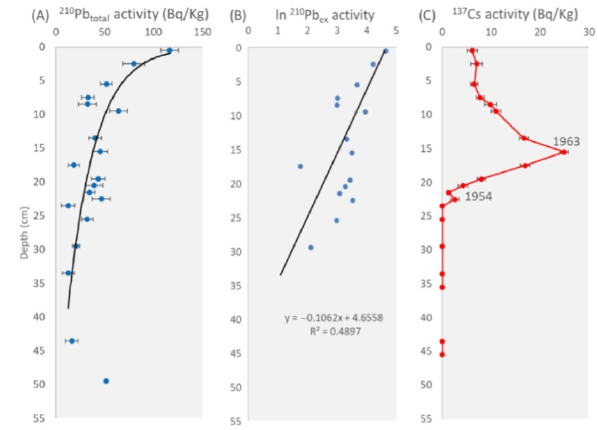
Figure A1. Profiles of the 210 Pb total activity ( A ), the Ln 210 Pb excess activity ( B ), and 137 Cs activity ( C ) of the high marsh core.